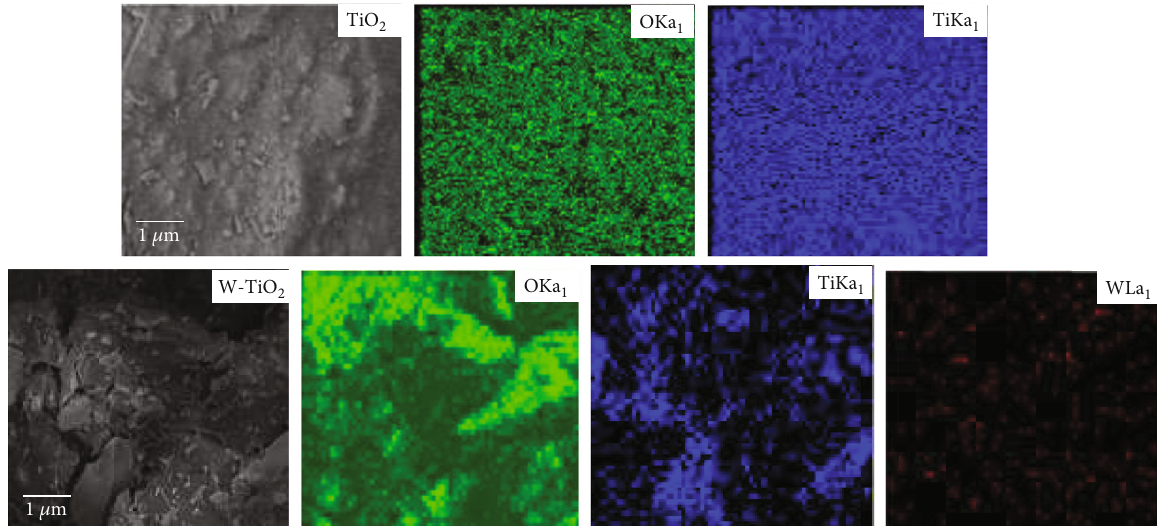
Figure 4: Element distribution mappings for the TiO